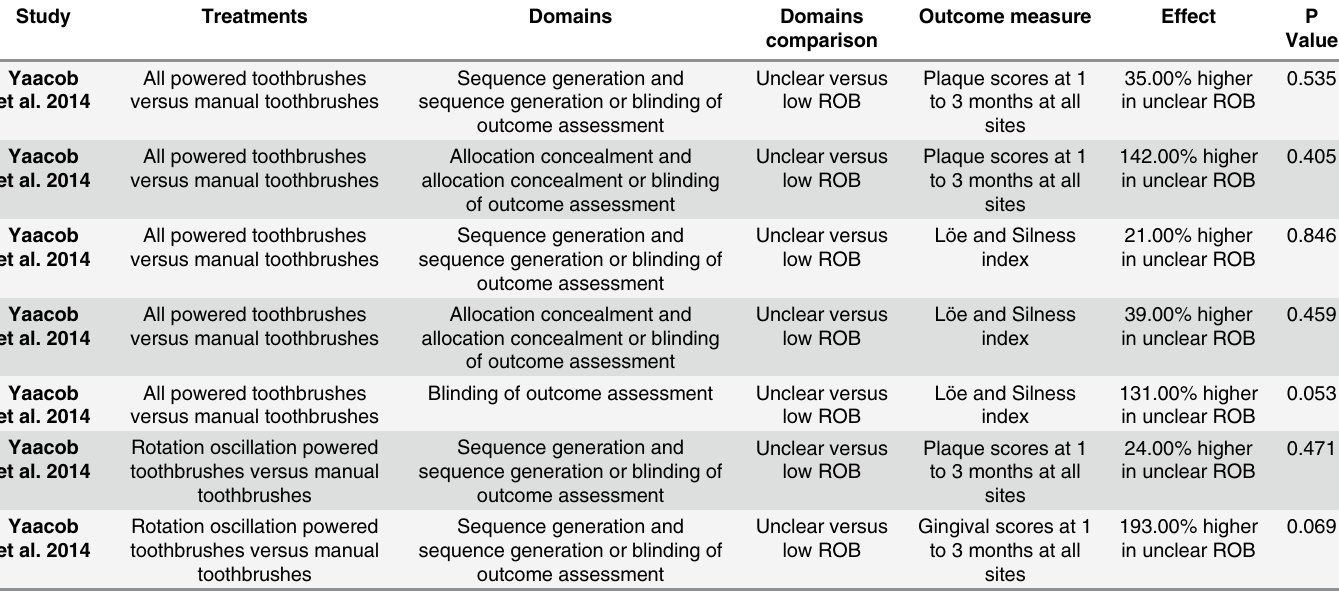
Table 3. Magnitude of the influence (in percentage) of different levels of risk of bias on the treatment effect estimates (only comparisons with at least 5 studies in each ROB